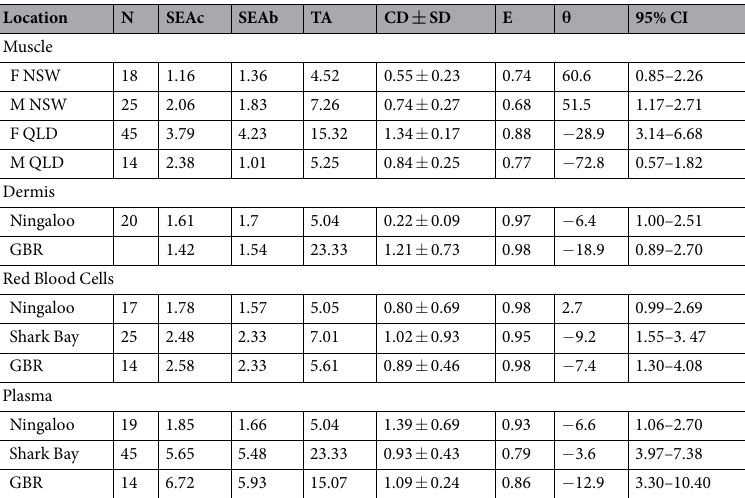
Location N SEAc SEAb TA CD ± SD E θ 95% CI Muscle F NSW